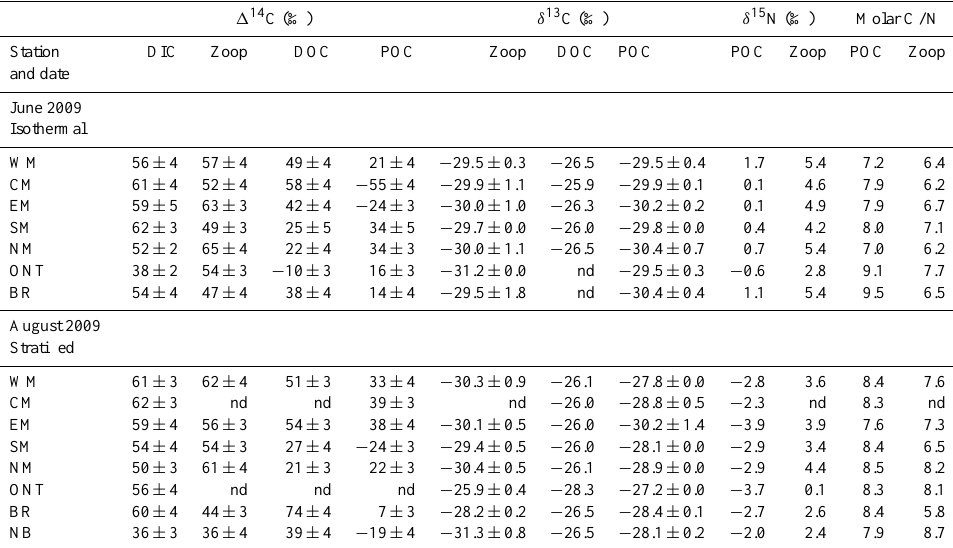
The C : N values of mesozooplankton ranged from 5.8 to 8.7 (mean 7.1, n = 14), and were consistently and signifi- cantly lower than the C : N values (C : N, mean 8.2, range 7.0 to 9.5) of bulk POM (t test, p = 0 . 001, n = 14) (Table 2).